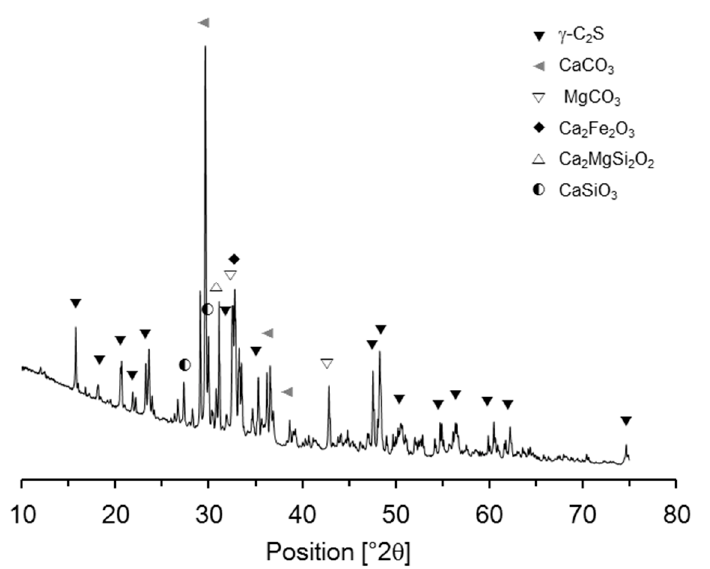
Figure 1. XRD pattern of the AOD slag.